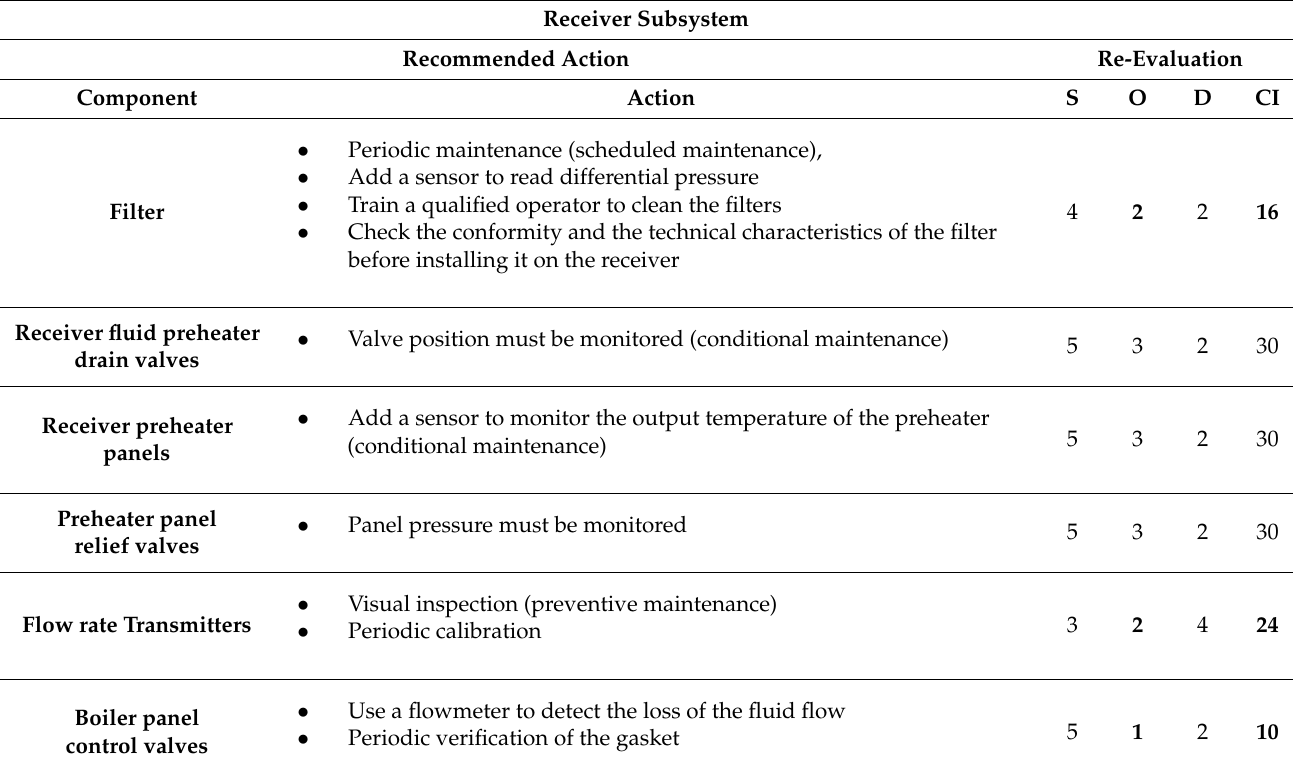
Table 10. Recommended maintenance actions for STPP to reevaluate the